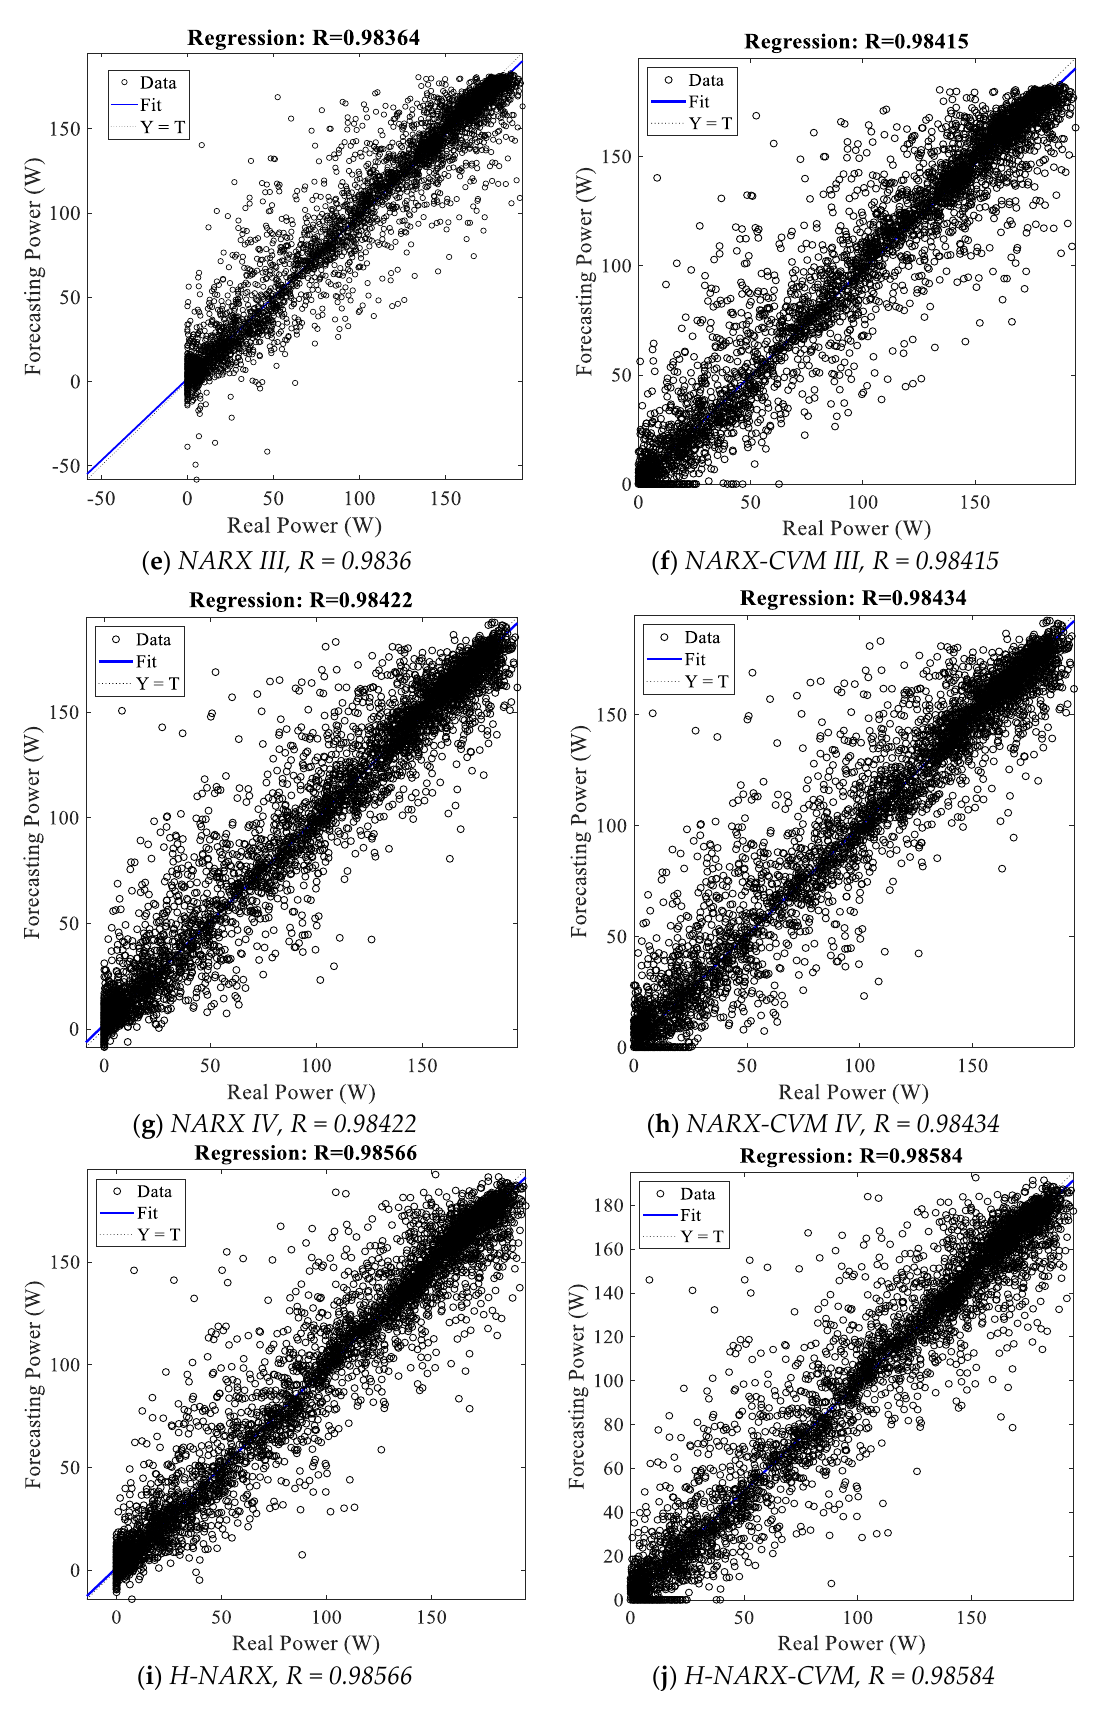
Figure 11. Linear regression analysis for the five study cases: models without CVM at the top and models with CVM at the bottom.